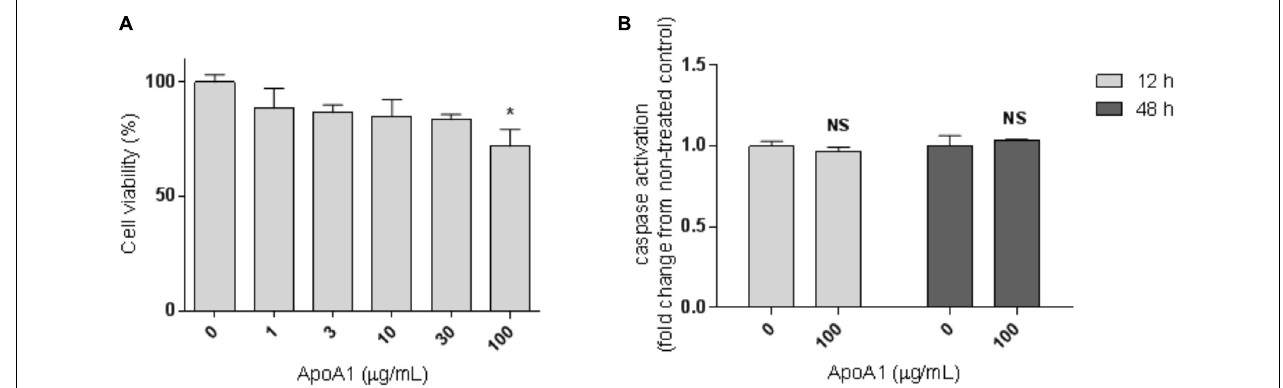
FIGURE 1 | ApoA1 decreases the viability of ovarian cancer cells without affecting caspase activation. (A) SKOV3 cells were incubated with human ApoA1 up to a concentration of 100 µ g/mL in serum-free conditions for 48 h. Untreated cells were exposed to vehicle only. ApoA1 treatment significantly decreased the viability of SKOV3 cells (Kruskal–Wallis test with Dunn’s multiple comparison post-test; p < 0.05). (B) SKOV3 cells were incubated with 100 µ g/mL ApoA1 for 12 h (light gray bars) and 48 h (dark gray bars). Caspase 3/7 activation was quantified and normalized to the number of viable cells. No differences were observed in caspase activation between untreated cells and cells exposed to ApoA1. Differences were considered significant if p < 0.05. ∗ p < 0.05.